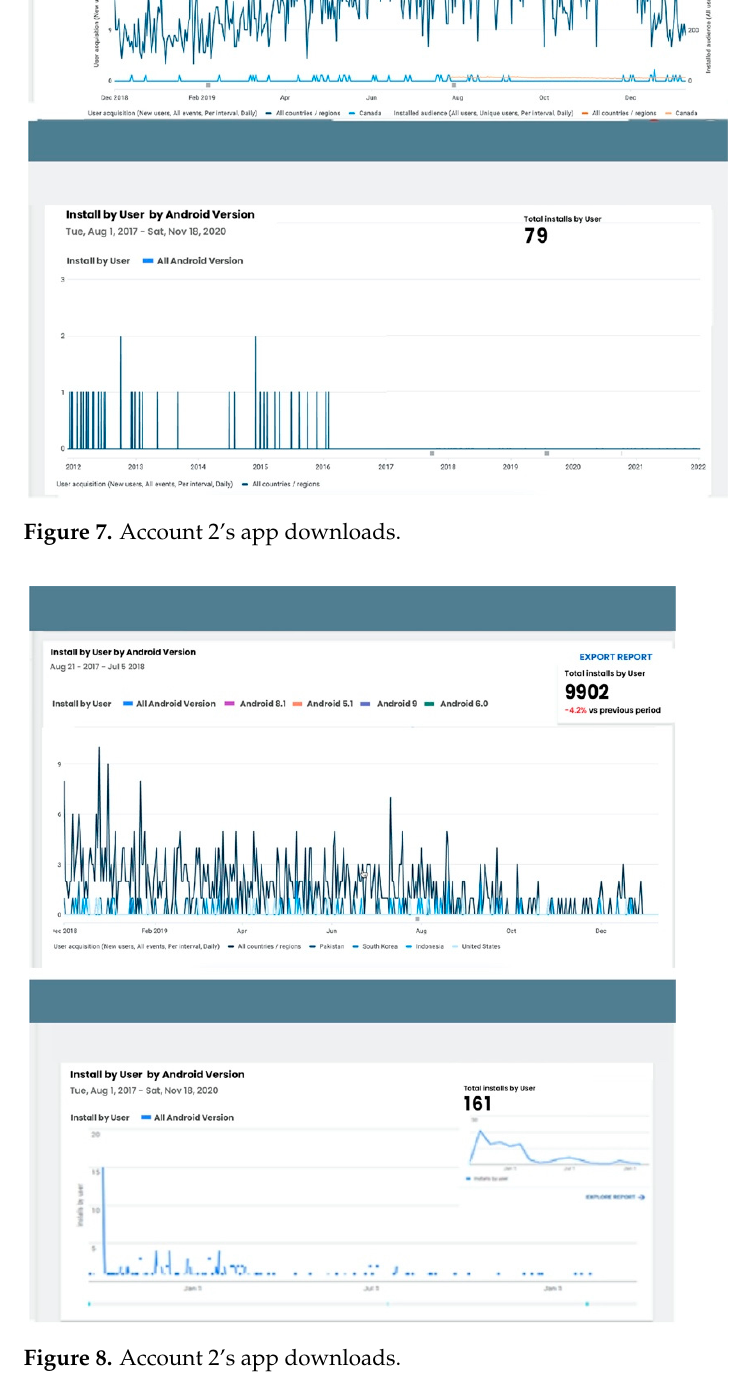
Figure 8. Account 2’s app downloads.